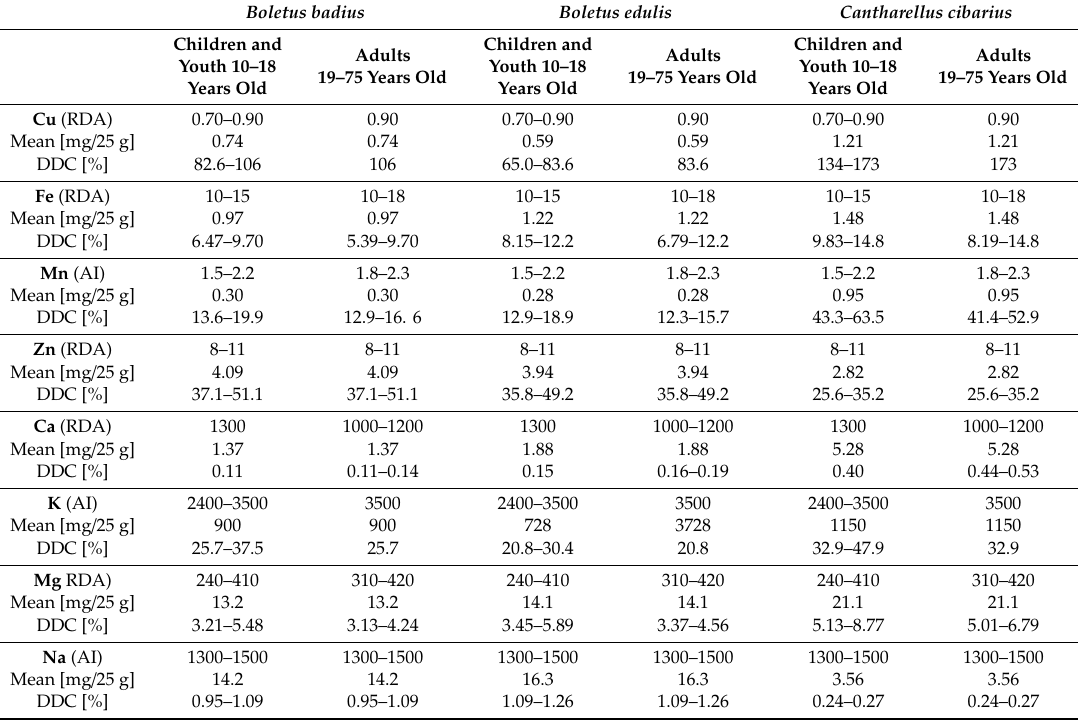
Table 2. Coverage of the daily demand for minerals after eating 25 g of dried mushrooms. Boletus